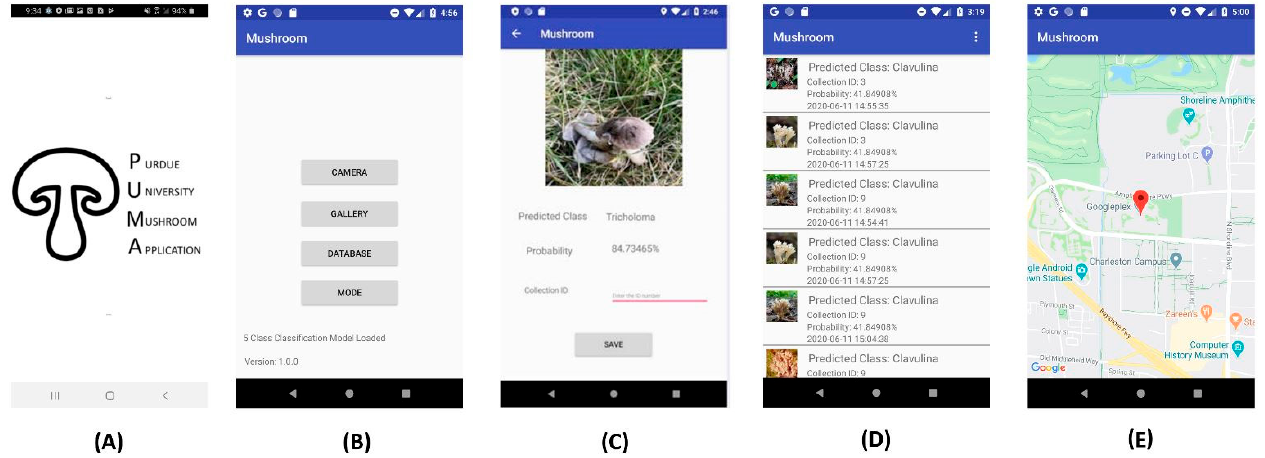
Figure 5. Screenshot of PUMA. ( A ) starting screen ( B ) initial menu where the user can select the app functions. ( C ) Results screen where the predicted class with respective probability is shown.